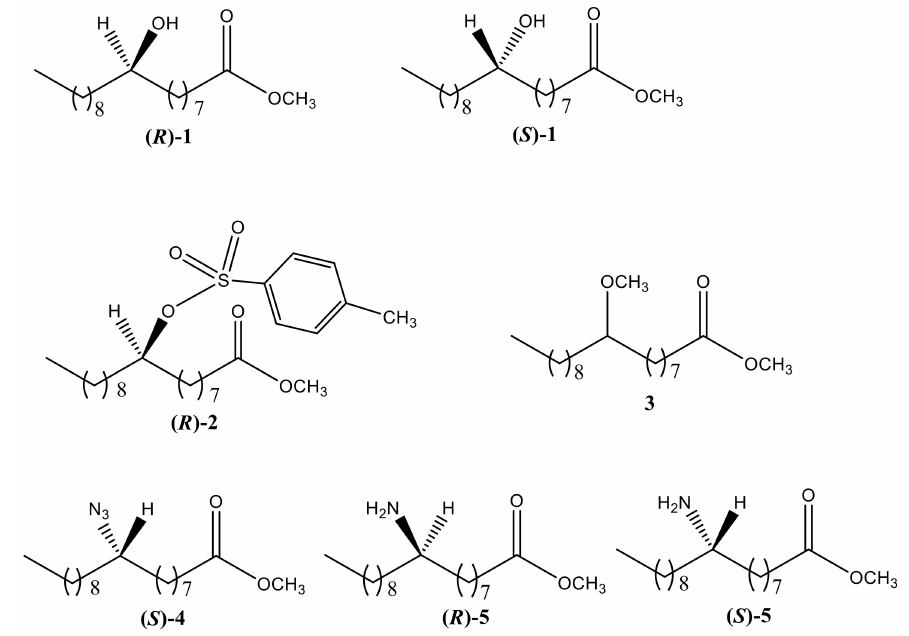
Figure 2. 9-HSA derivatives synthesized and biologically